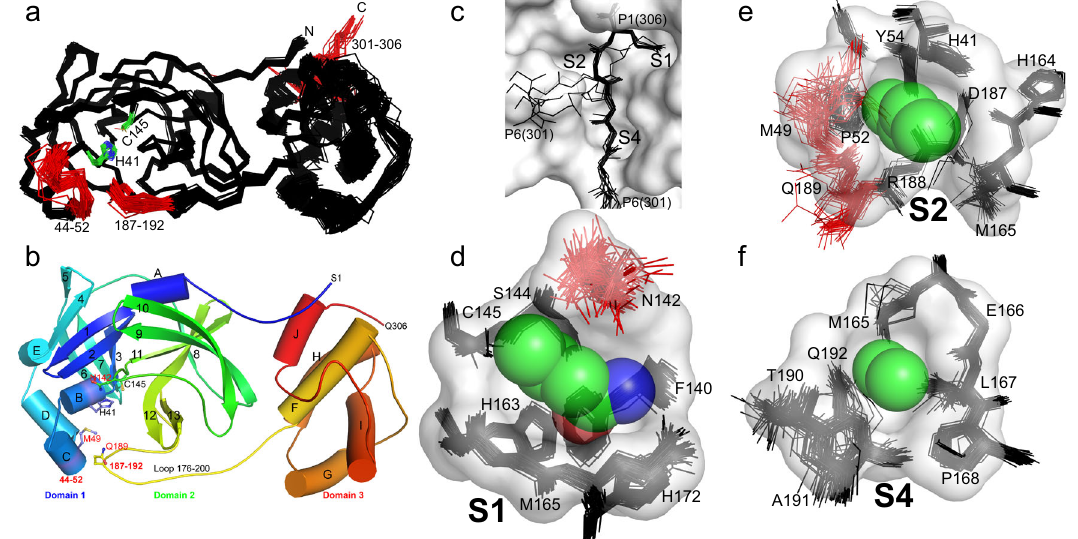
Fig. 4 | Plasticity of SARS-CoV-2 M pro to promote molecular recognition of the polyprotein cleavage site variants. a Global structural alignment of all unique chains from the multiple structures characterized in this study. Structural align- ments were performed using the ALIGN function in PyMOL with all protein atoms. Mobile regions are highlighted in red and labeled. Catalytic dyad H41/C145 are shown with green carbons and labeled. b M pro cartoon highlighting secondary structural features, oriented as in panel a , colored spectrally - blue N-terminus to red C-terminus. c Overlay of representative P6to P1 regionsobservedamongstthe distinct cleavage site structures, highlighting their varying main chain conforma- tions. The majority adopt the canonical extended β -type conformation within the